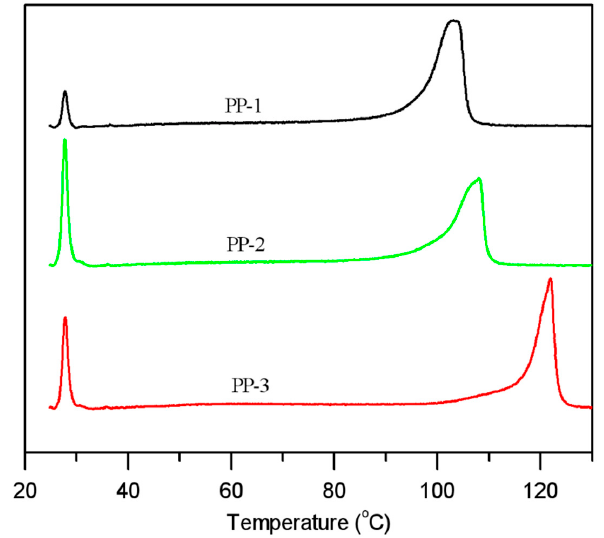
Figure 8. Temperature rising elution fractionation (TREF) results.